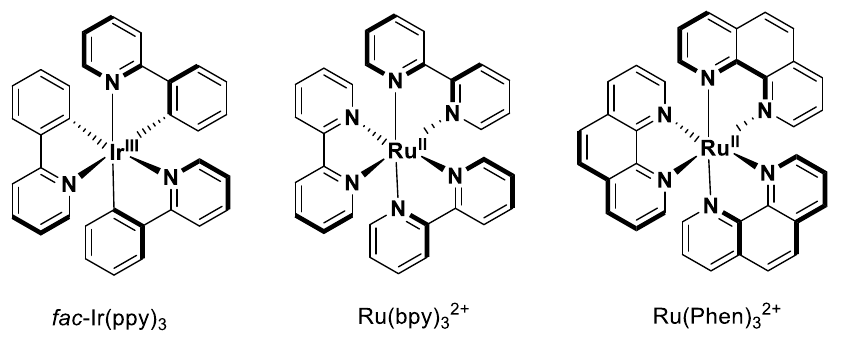
Figure 2. Common photocatalysts used in halotrifluoromethylation reactions.